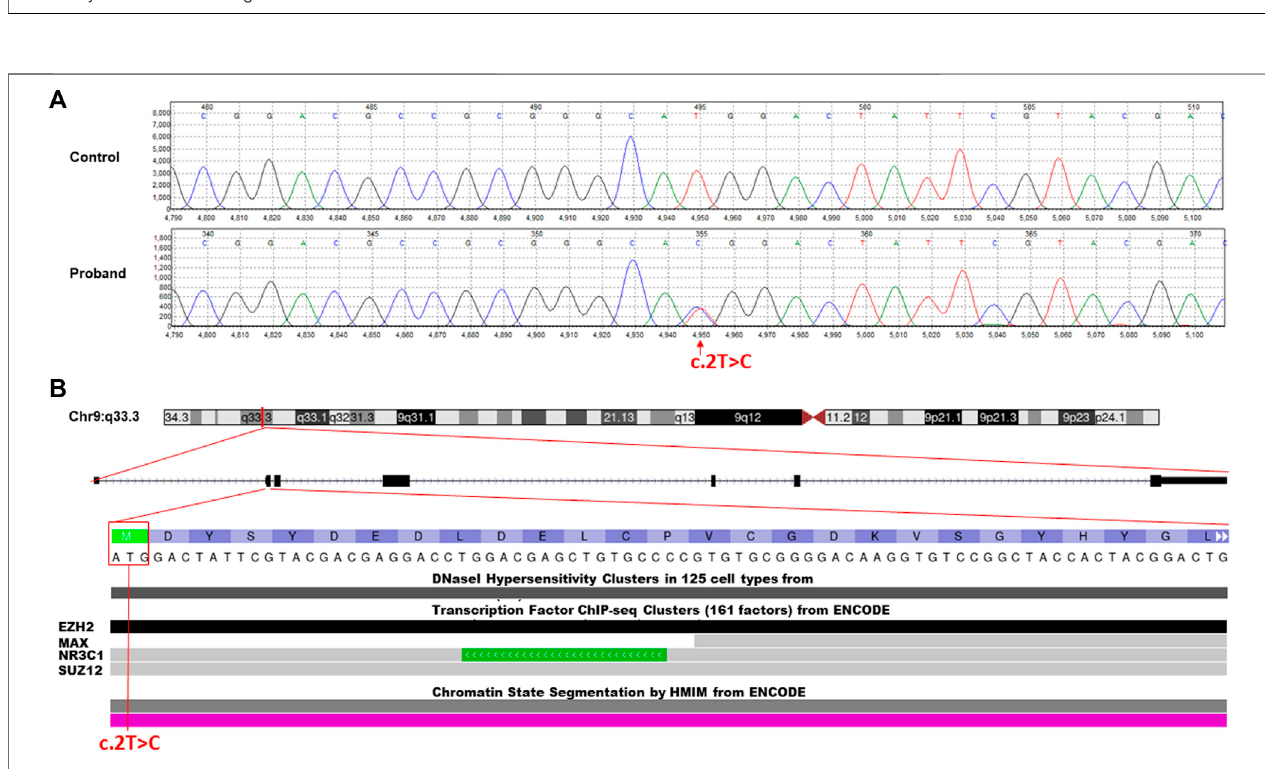
FIGURE2| Molecularcharacterizationoftheidenti fi edc.2T > Cmissensevariantinthe NR5A1 gene. (A) ChromatogramofSangersequencingsegregationanalysis of the wild-type control and affected proband. Red arrow represents the identi fi ed variant. (B) Annotation of the identi fi ed missense variant in the NR5A1 gene (c.2T > C, p.Met1Thr) is located on chromosome 9p33.3. The variant falls in the fi rst transcribed exon (exon 2) of the N-terminal region and interrupts the starting codon (ATG > ACG). The variant located in some of the ENCODE functional data tracks in the USCS genome browser (http://genome.ucsc.edu/). The variant interrupt DNaseI hypersensitivity and some predicted transcription factor binding sites (TFBSs) such as EZH2, NR3C1, and SUZ12.